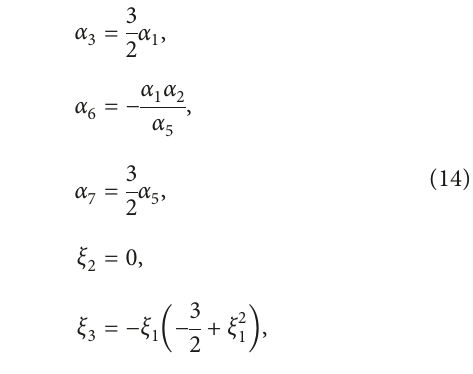
� 1 , α � 1 , α � 0 , α � 1 , α � 0 , α � 1 , and t � 1; (b) contour map in the ( x , y ) 1 2 4 5 8 9